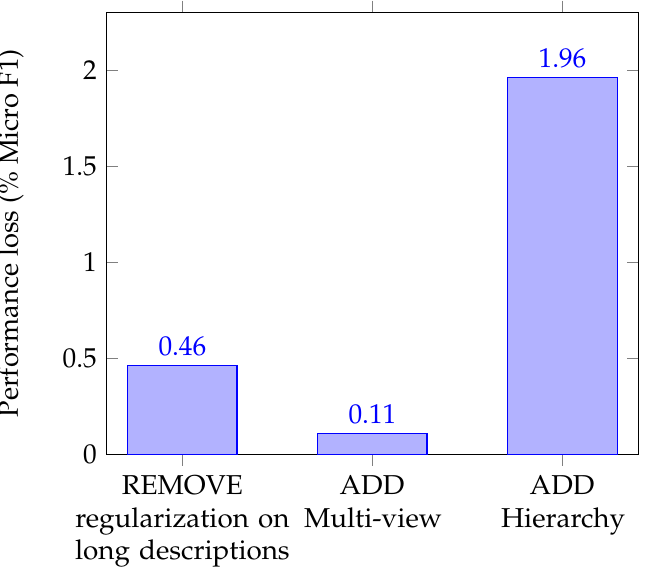
Figure 8. Ablation study on highest performing model (hierarchical MVC-RLDA) for MIMIC-III dataset. Table 7. Results of flat models on top 50 codes obtained on the CodiEsp dataset.